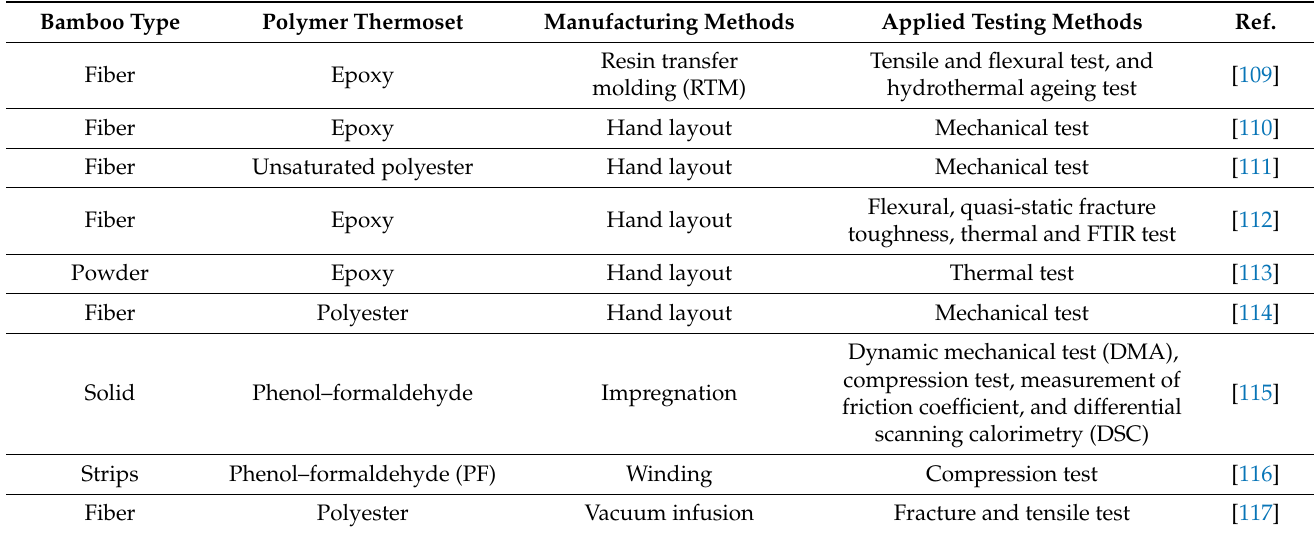
Table 10. Common bamboo-reinforced thermoset polymer composites from the